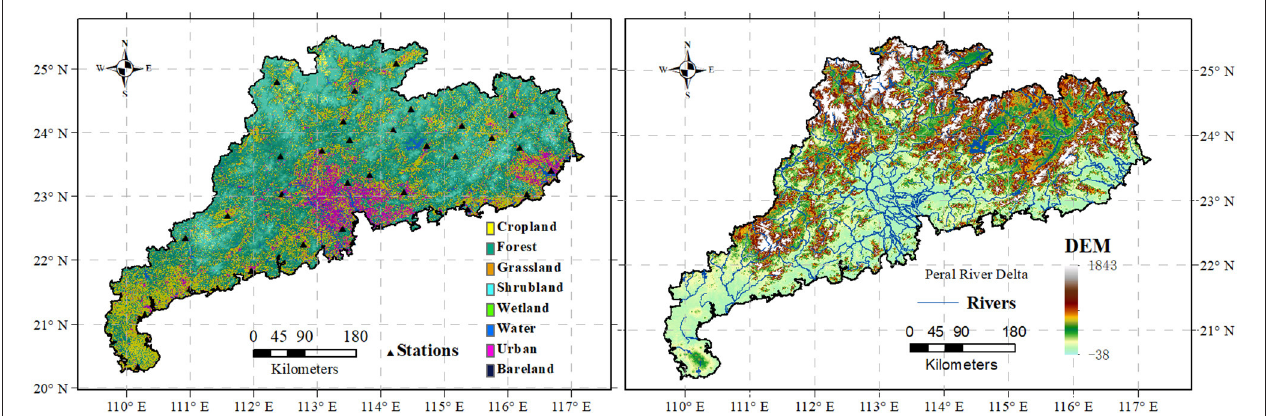
FIGURE 1 | Land use land cover types of Guangdong province at a 30-m resolution (left); and digital elevation map at a 1,000-m resolution (right). Locations of the meteorological stations are marked with black